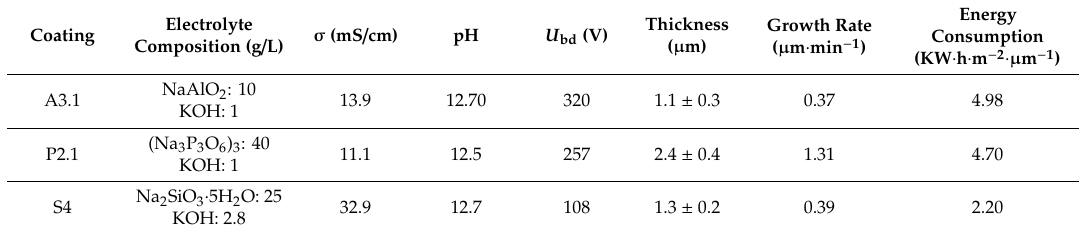
Table 3. Energy consumption values and electrolytes characteristic of selected flash PEO